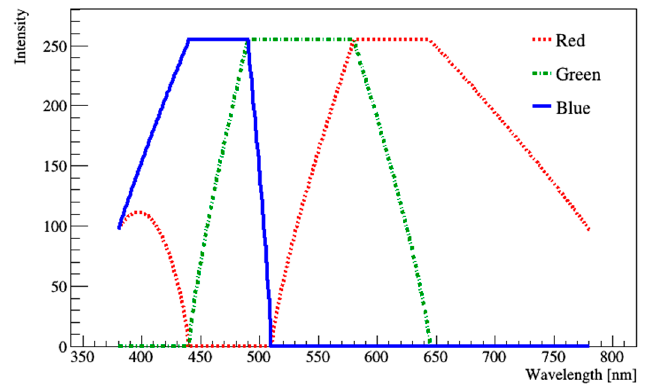
Figure 1. ( a ) Experimental setting for generating lights using LED disc. LED disc was connected to a single-board Arduino. ( b ) Schematic for taking digital image photo. Black foam was used as an L- shaped wall. The light from the hole passed through the grating or was directly imaged on the screen depending on the purpose of the experiment. ( c ) RGB intensity as a function of wavelength. ( d ) RGB color and corresponding wavelength. Light from blue to red was generated. Photographs were taken in increments of 10 nm with wavelengths ranging 380 to 645 nm.